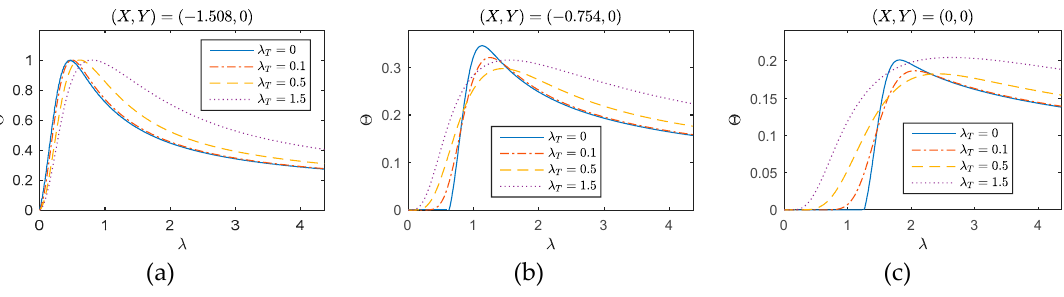
behavior λ T = 1.5.